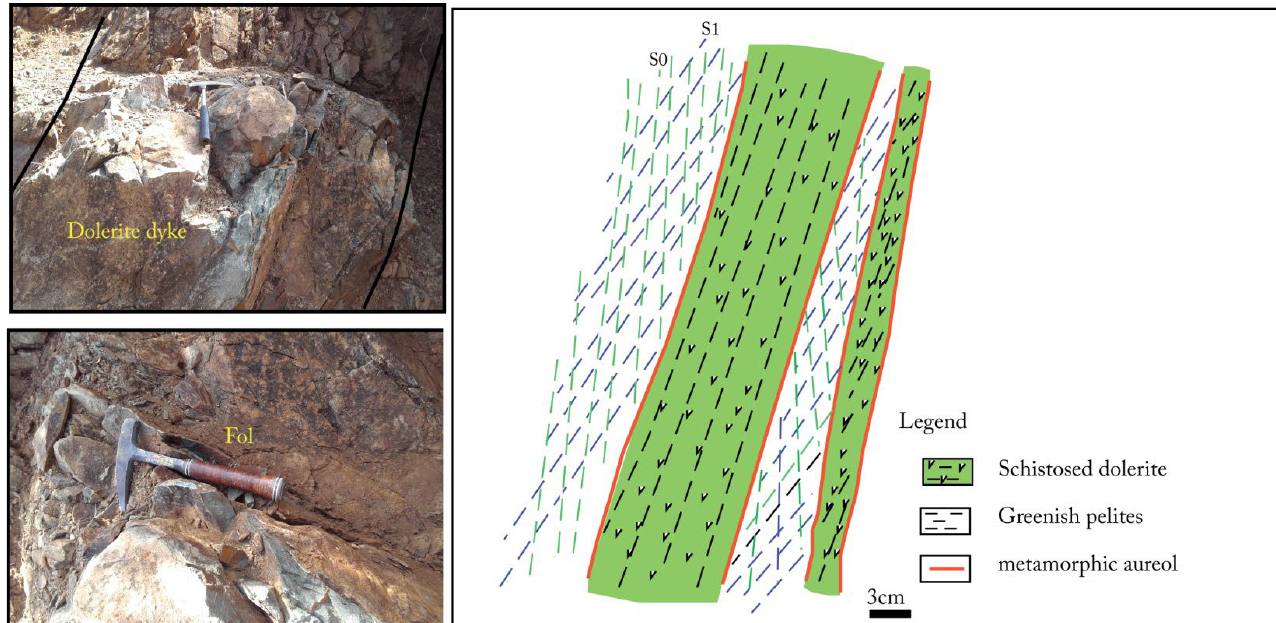
Figure 14. Foliation (Fol) in outcropping dolerites.